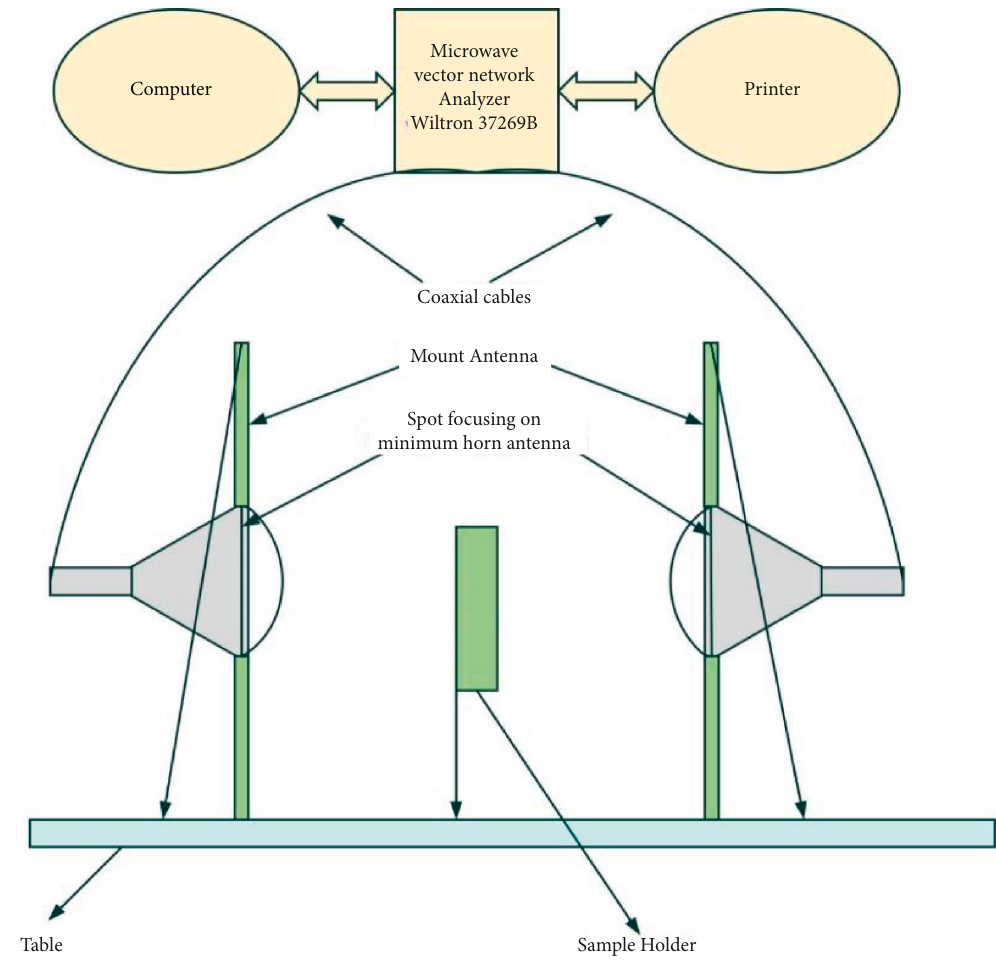
Figure 3: Free space microwave method.